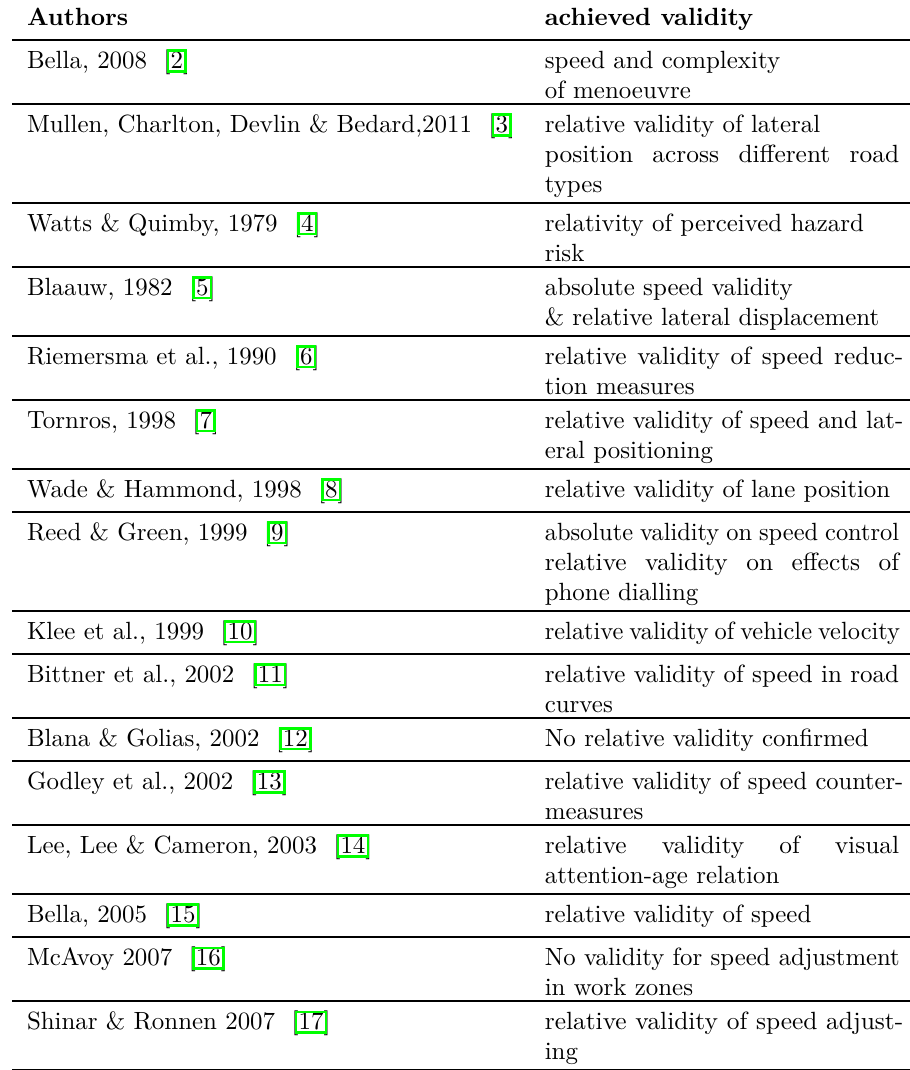
Table 1. Studies elaborating driving simulator